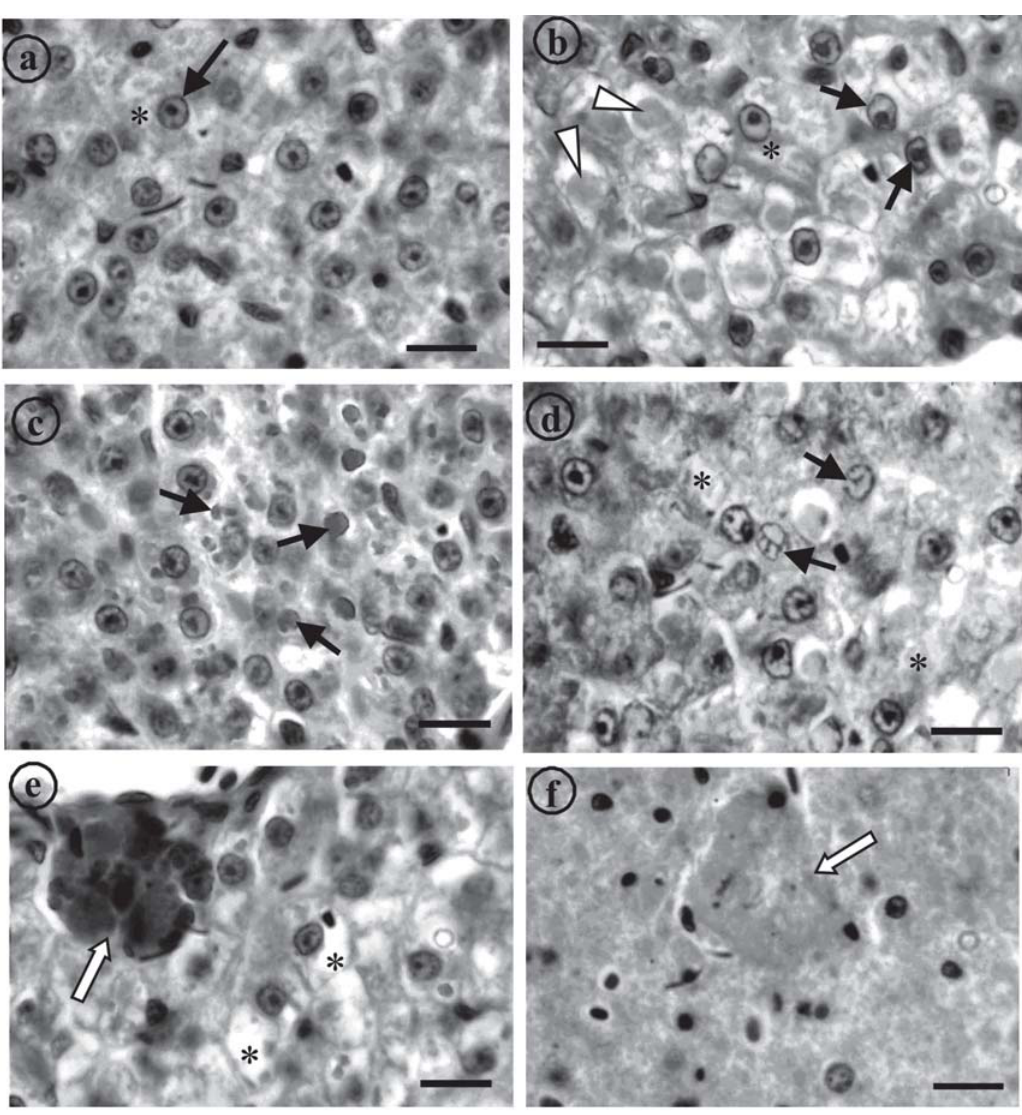
Fig. 4. Photomicrographs of the liver of P. lineatus caged in Cambé stream. a) normal hepatic tissue, showing hepatocytes with granular cytoplasm (*) and central and round nucleus (arrow); b) hepatocytes with irregular shaped nucleus (black arrows), eosinophilic granules in the cytoplasm (arrowheads) and nuclear hypertrophy (*); c) bile stagnation (arrows); d) nuclear degeneration (arrows) and cytoplasmic degeneration (*); e) melanomacrophages aggregate, close to a vessel (white arrow) and cytoplasmic vacuolation (*); f) hepatic tissue showing focal necrosis (white arrow). Scale bar 10 mm,